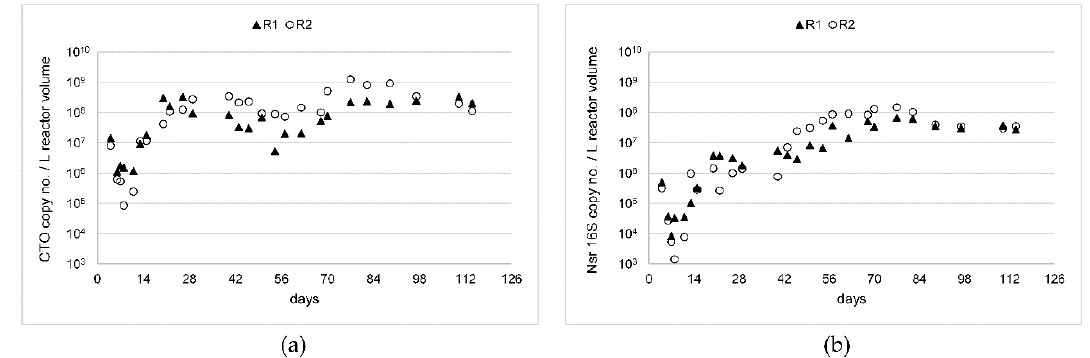
Figure 4. Results of the qPCR analyses. Gene copy numbers of ( a ) AOB 16S rRNA; and ( b ) Nitrospira (NOB) 16S rRNA. The y-axis on both graphs is shown in a logarithmic scale.